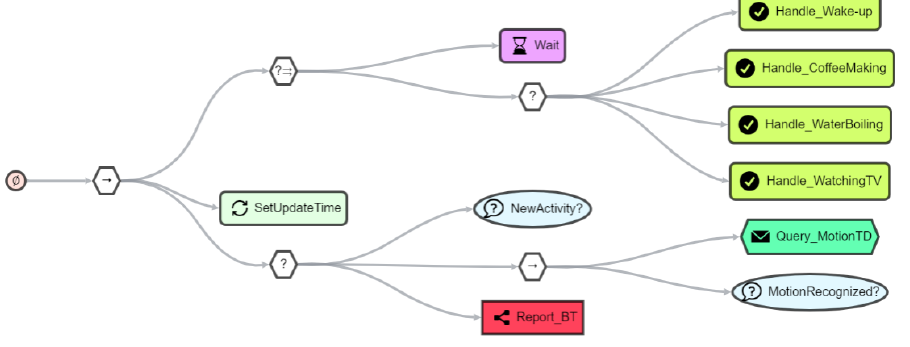
Figure 13. Use-Case emergency checking